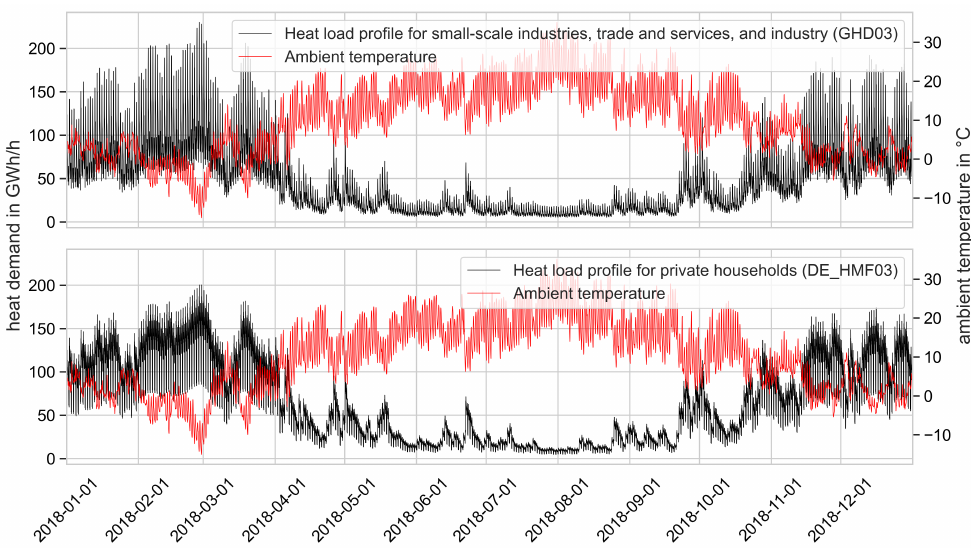
Figure 6. Example of a simulated heat load curve of space heating and water heating for households (upper part of the figure), small-scale industries, trade and services, and industry (lower part of the figure), and the ambient temperature using Germany’s example for 2018. The demanded heat load (shown in black) is inversely proportional to the ambient temperature (shown in red). Although the example shown represents the load profile of a country, the approach presented can also be applied to individual buildings or